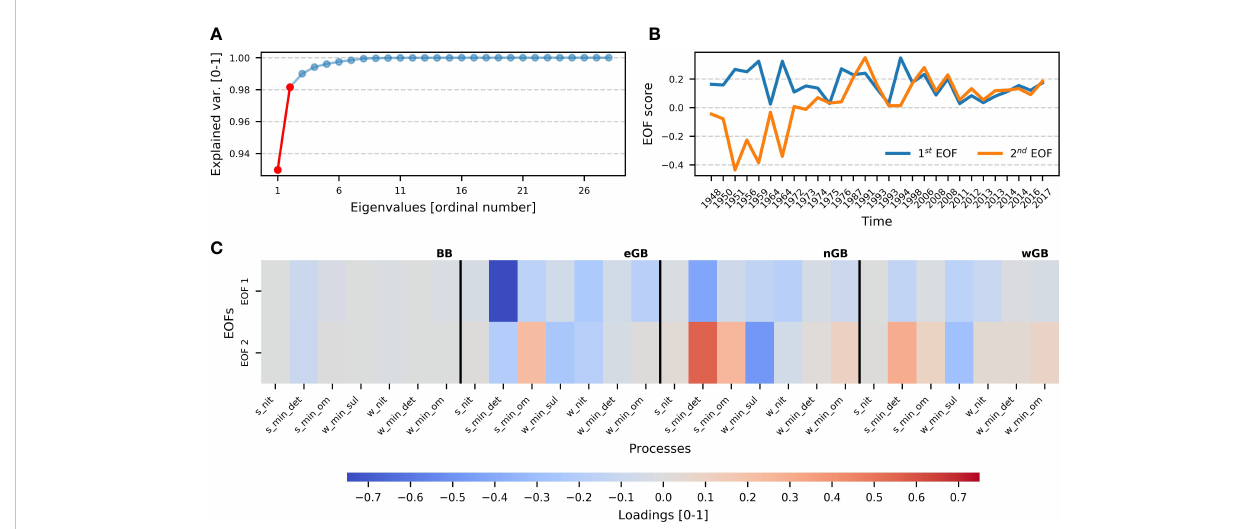
FIGURE 9 Results of the EOF analysis for oxygen consumption during in fl ow events. Panel (A) demonstrates the fraction of variance explained by the EOFs. The fi rst two EOFs (which explain more than 95% of the variance) are marked by red color. Only those two EOFs were considered. Panel (B) shows timeseries of the fi rst two EOFs. Note that the x-axis in panel A is not equidistant (see caption of Figure 8). The fi rst EOF exhibits a stationary pattern, whereas the second demonstrates some non-stationarity. Panel (C) shows the EOF loadings, which indicate how a certain EOF is connected to a certain process. Positive values (red) indicate a direct relationship between EOF and a process, negative (blue) - a reverse relationship. It is visible that the fi rst EOF shows reverse relationships with all processes, but the second shows both types of relationship. Processes are read the same way as in Figure 8, but with the ending indicating a certain sub-basin. The processes in the matrix are sorted in the following way: the Bornholm Basin, the eastern Gotland Basin, the northern Gotland Basin, and the western Gotland Basin. Black vertical lines denote the boundaries between sub-basins. See Supplementary Table 1 for the de fi nition of the names of